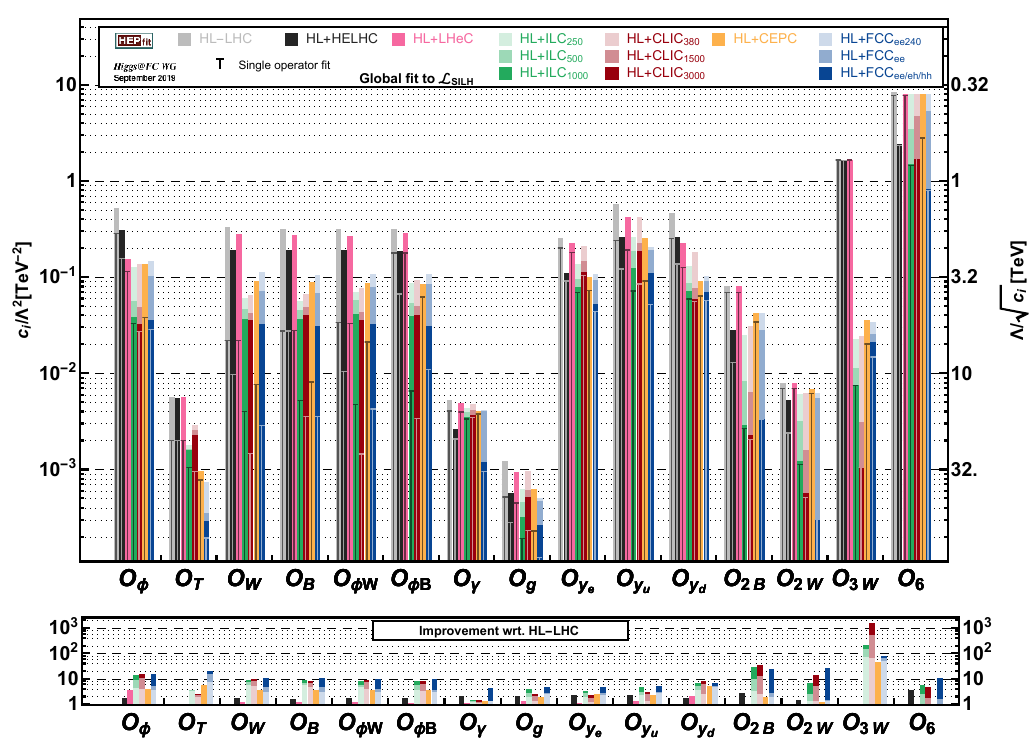
Figure 6 . Global (cid:12)t to the EFT operators in the Lagrangian (3.19). We show the marginalized 68% probability reach for each Wilson coe(cid:14)cient c i = (cid:3) 2 in eq. (3.19) from the global (cid:12)t (solid bars). The reach of the vertical \T" lines indicate the results assuming only the corresponding operator is generated by the new physics. The HE-LHC results correspond to the S 0 theory systematic uncertainties in Higgs processes